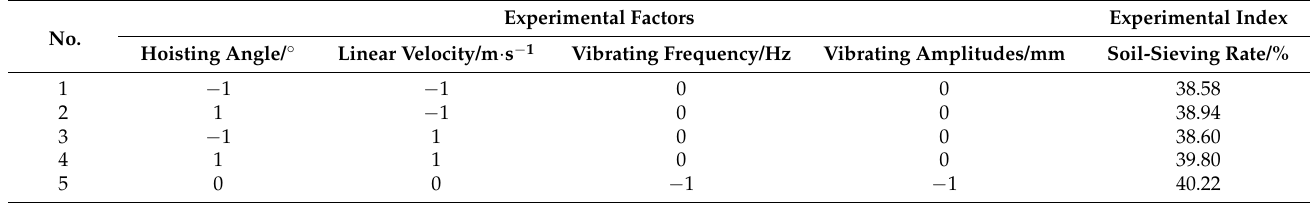
Table 4. Experiment scheme and